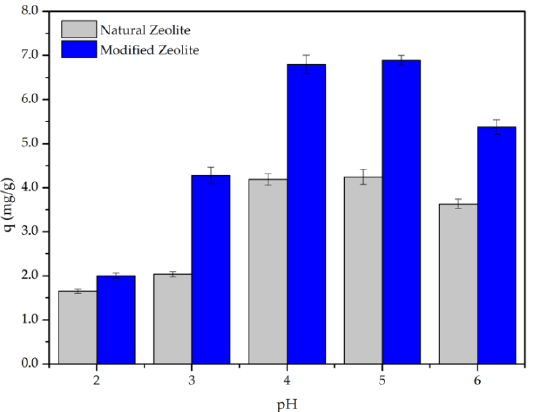
◦ C, t = 8 h, n = 100 rpm). 0 = 100 mg/L, T = 25